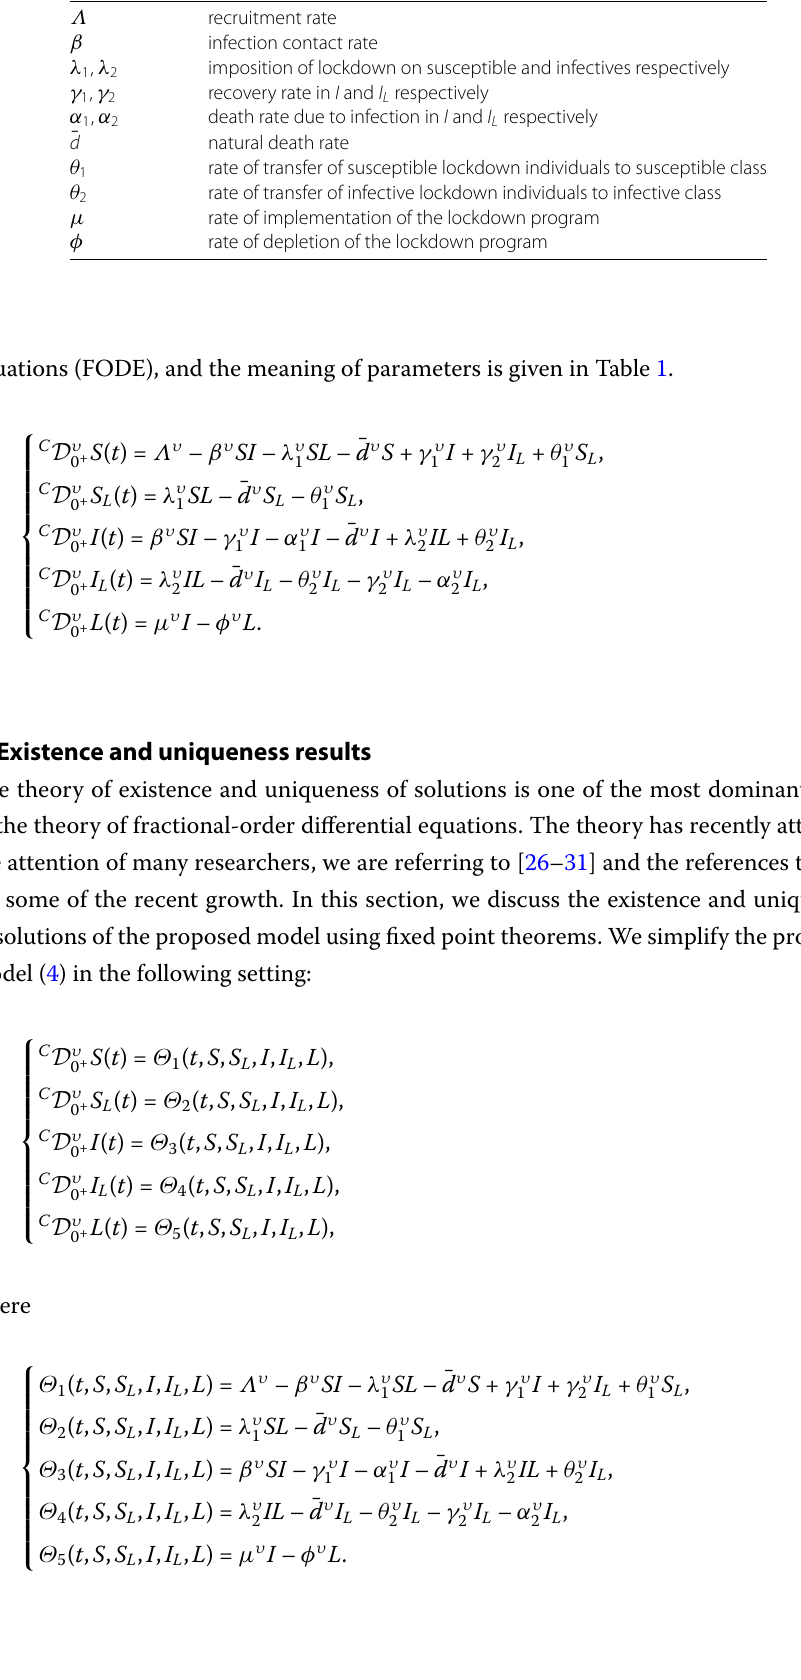
Table 1 Description of the parameters Parameter Description Λ recruitment rate β infection contact rate λ 1 , λ 2 imposition of lockdown on susceptible and infectives respectively γ 1 , γ 2 recovery rate in I and I L respectively α 1 , α 2 death rate due to infection in I and I L respectively ¯ d natural death rate θ 1 rate of transfer of susceptible lockdown individuals to susceptible class θ 2 rate of transfer of infective lockdown individuals to infective class μ rate of implementation of the lockdown program φ rate of depletion of the lockdown